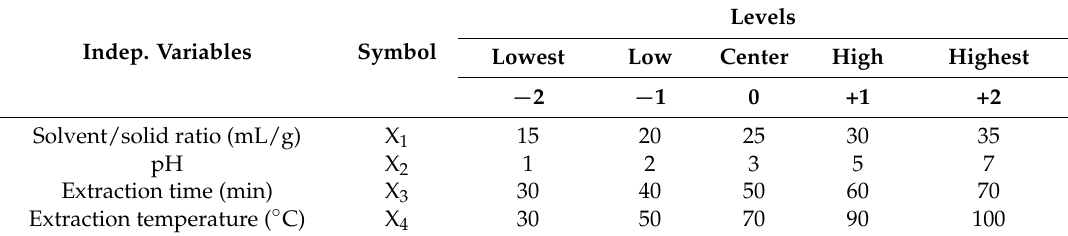
Table 1. Coded levels (at five levels of lowest, low, center, high and highest coded as − 2, − 1, 0, +1, and +2, respectively) of independent variables used in the central composite design (CCD). Levels Indep. Variables Symbol Lowest Low Center High